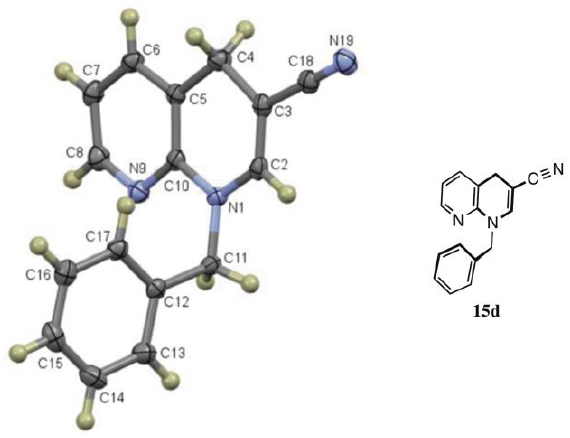
Figure 3. X-ray structure of 1-benzyl-1,4-dihydro-1,8-naphthyridine-3-carbonitrile ( 15d , CCDC 2035027).